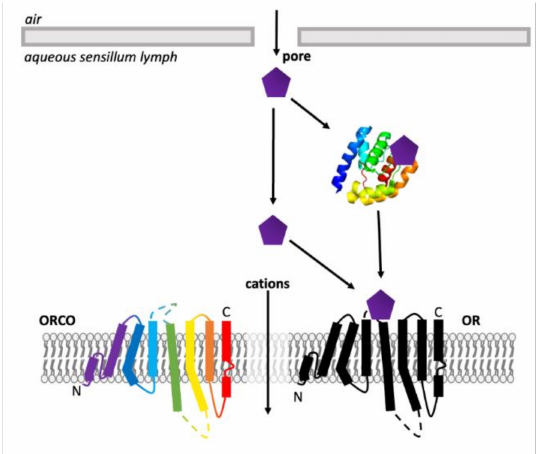
Figure 5. General olfactory processing in insects. Within the antennal sensilla, odorant-binding proteins (OBPs) play a role in allowing odorants to activate odorant receptors (ORs) which are co- expressed with the olfactory receptor co-receptor (ORCO). Once activated, an action potential travels along the odorant receptor neuron (ORN) to the antennal